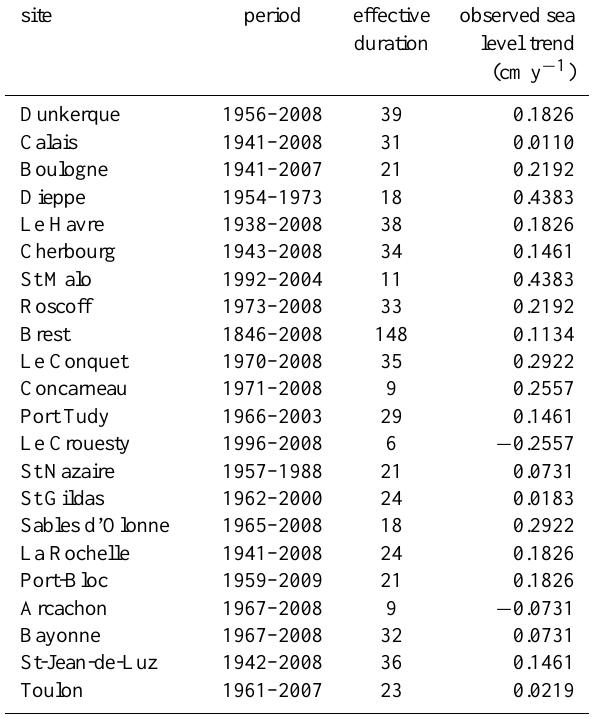
Table 1. Characteristics of the different sites of the study: global period of observation, effective duration of observation in years, and linear trend of the sea level evolution (centimeters per year).